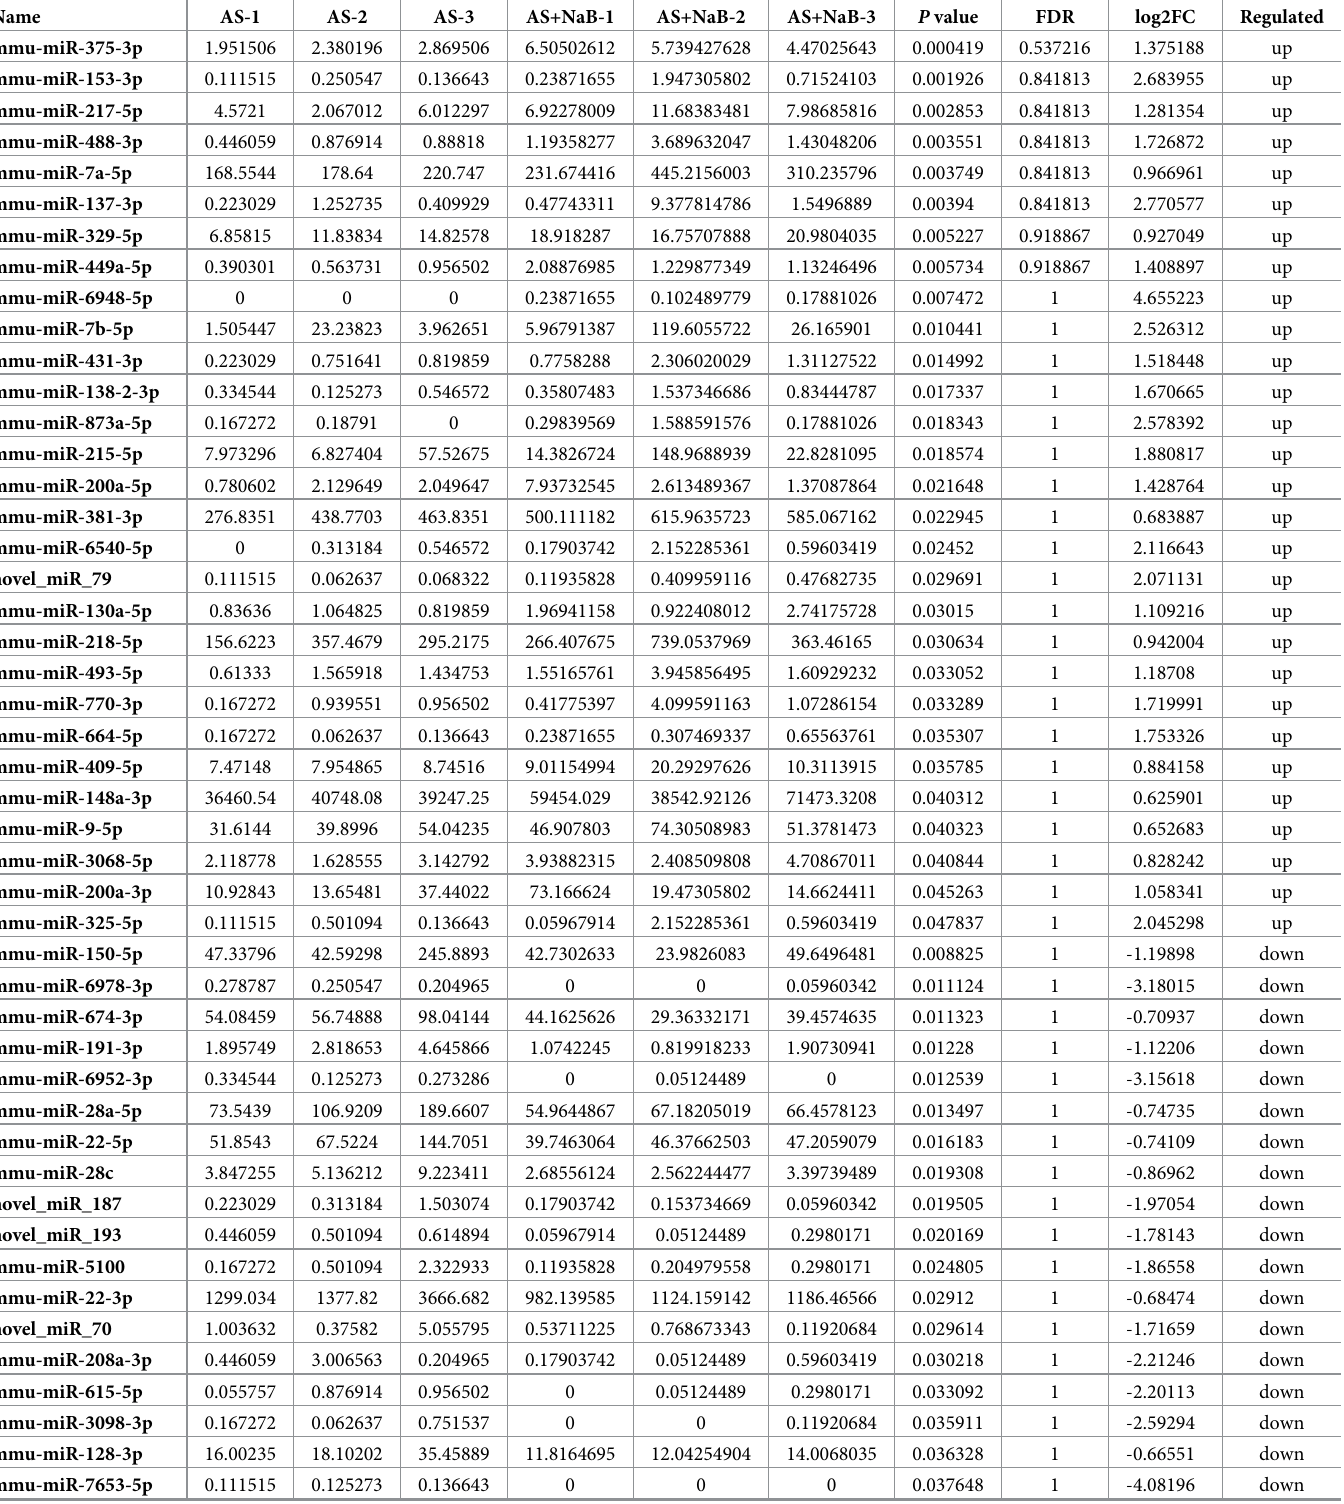
Table 2. Differential